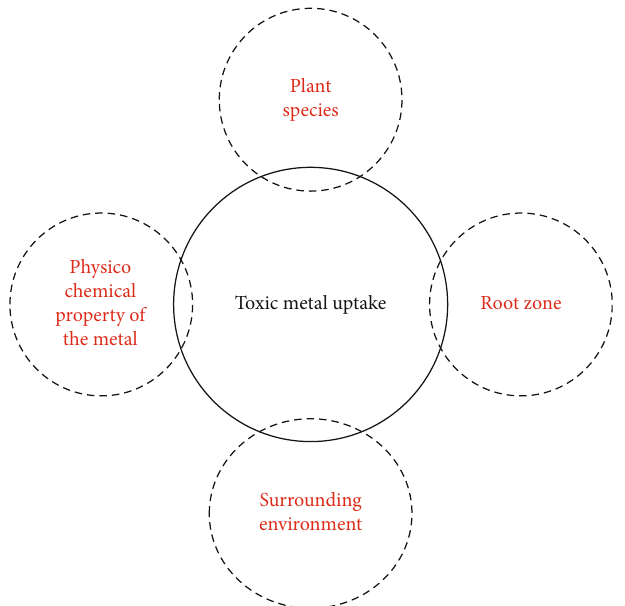
Figure 4: Plant contamination factors by toxic